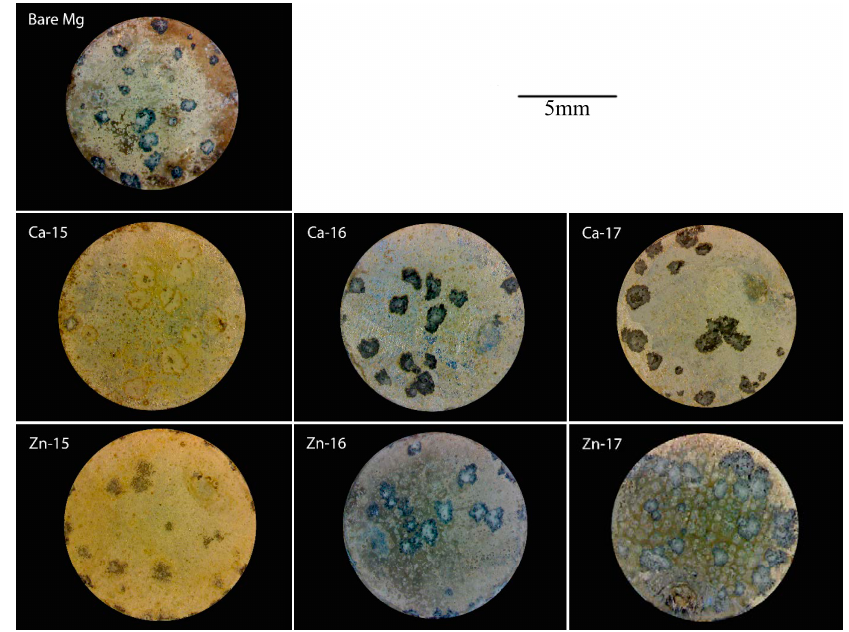
Figure 4. Macrographs of Ca-ion and Zn-ion implanted magnesium after potentiodynamic polarisation in SBF.